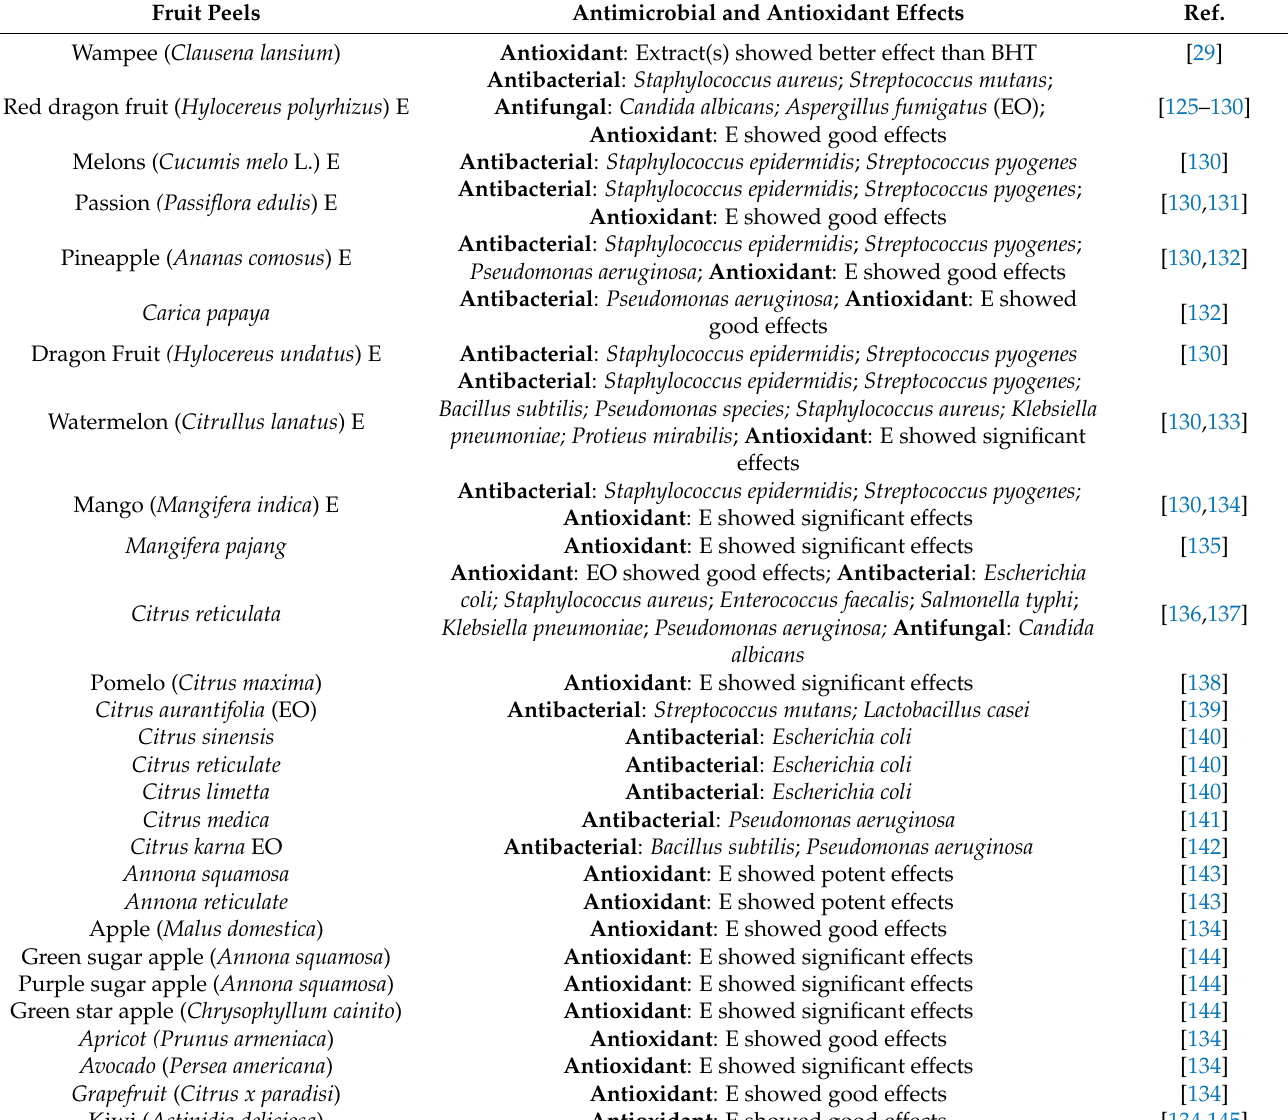
Table 1. Antimicrobial and antioxidant effects of fruit peel extracts and essential oils. Fruit